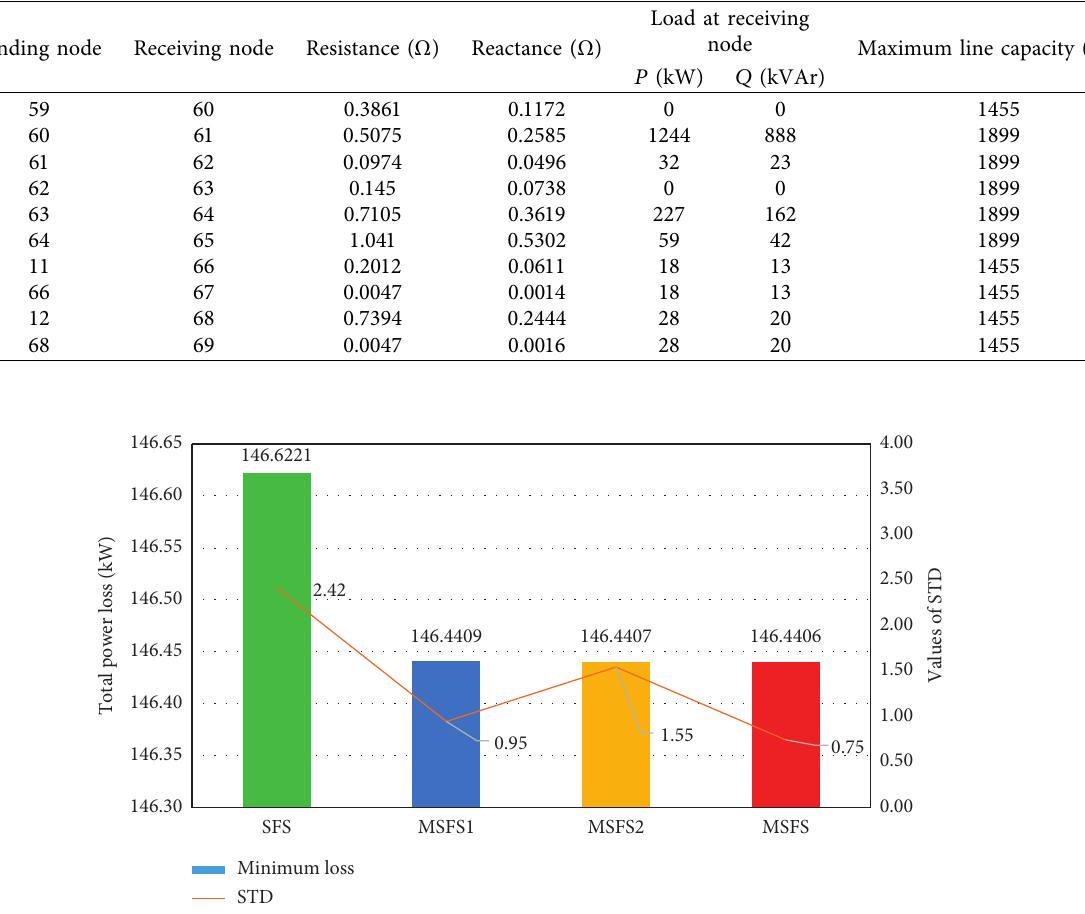
Figure 11: Minimum power loss and standard deviation of 50 trial runs obtained by SFS methods for case 1 of the 69-bus system.